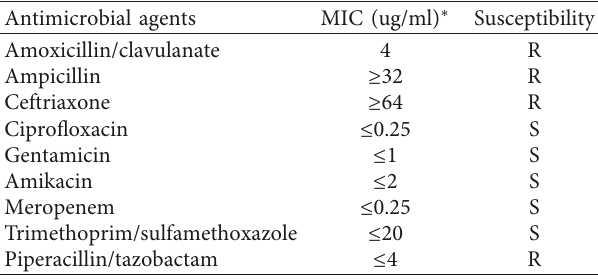
Table 1: Leclercia adecarboxylata antibiotic susceptibility profile. Antimicrobial